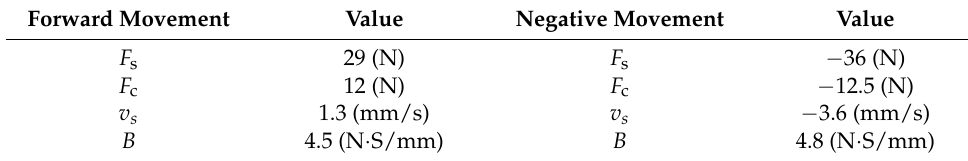
Table 2. Stribeck friction model parameter values.